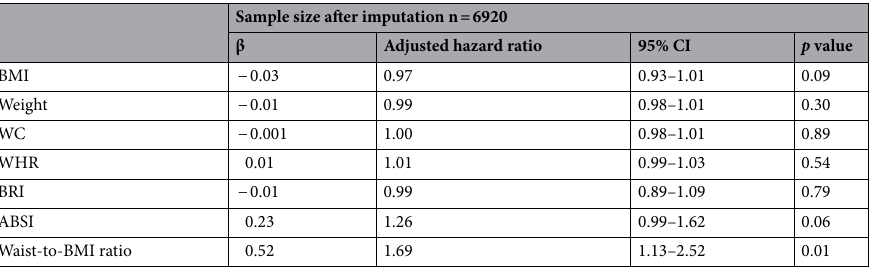
Table 4. Dose response association between various anthropometric parameters and risk of MACE in ASCVD patients examined using the Cox proportional hazards regression model. Each model was adjusted for age, sex, history of cigarette smoking, medical history of hypertension, diabetes mellitus, heart failure, CAD and stroke or transient ischemic attack, previous coronary intervention, statin use and its intensity, other medication, levels of non-HDL cholesterol and levels of eGFR. ABSI A body shape index, BMI Body mass index, BRI Body roundness index, WC Waist circumference, WHR Waist-hip